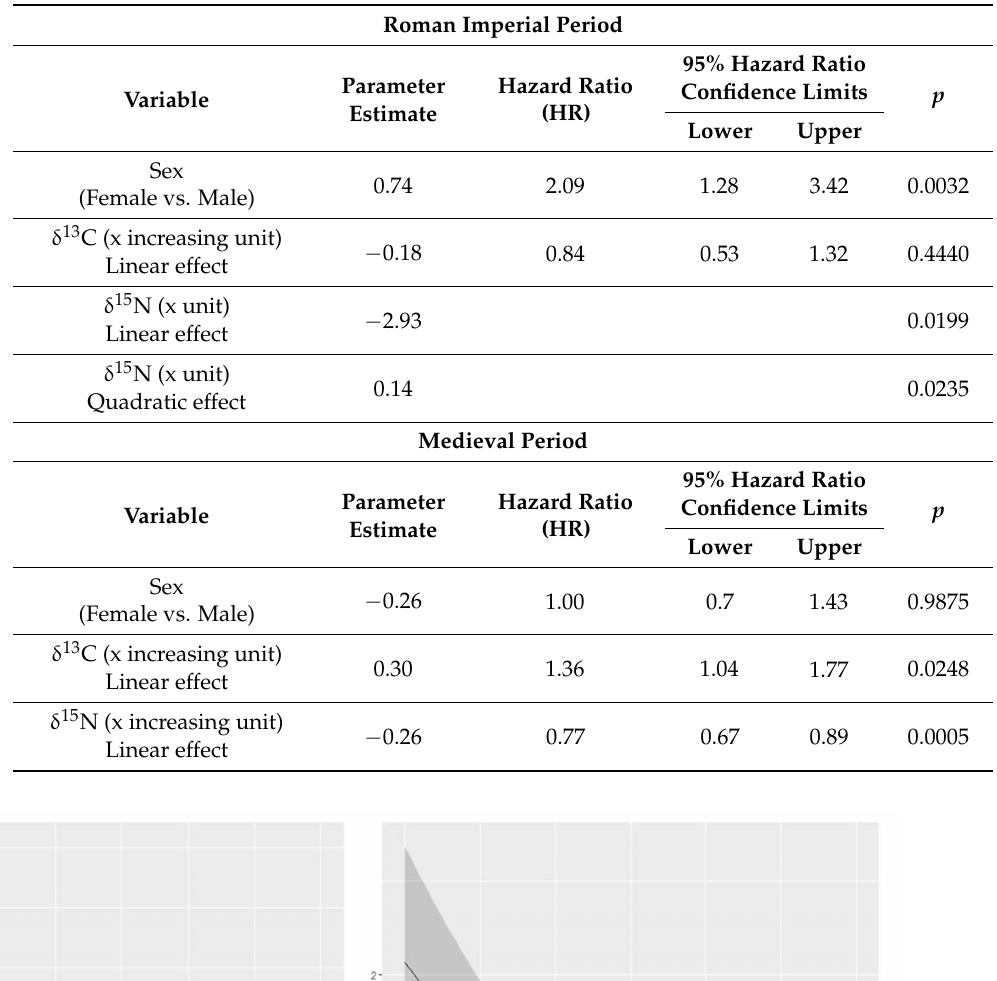
Table 1. Results from the Cox’s model. The significance threshold was set to p = 0.05. The reference level for sex was “Male”. In the case of a linear effect, the Hazard Ratio (HR) was intended for increasing units.